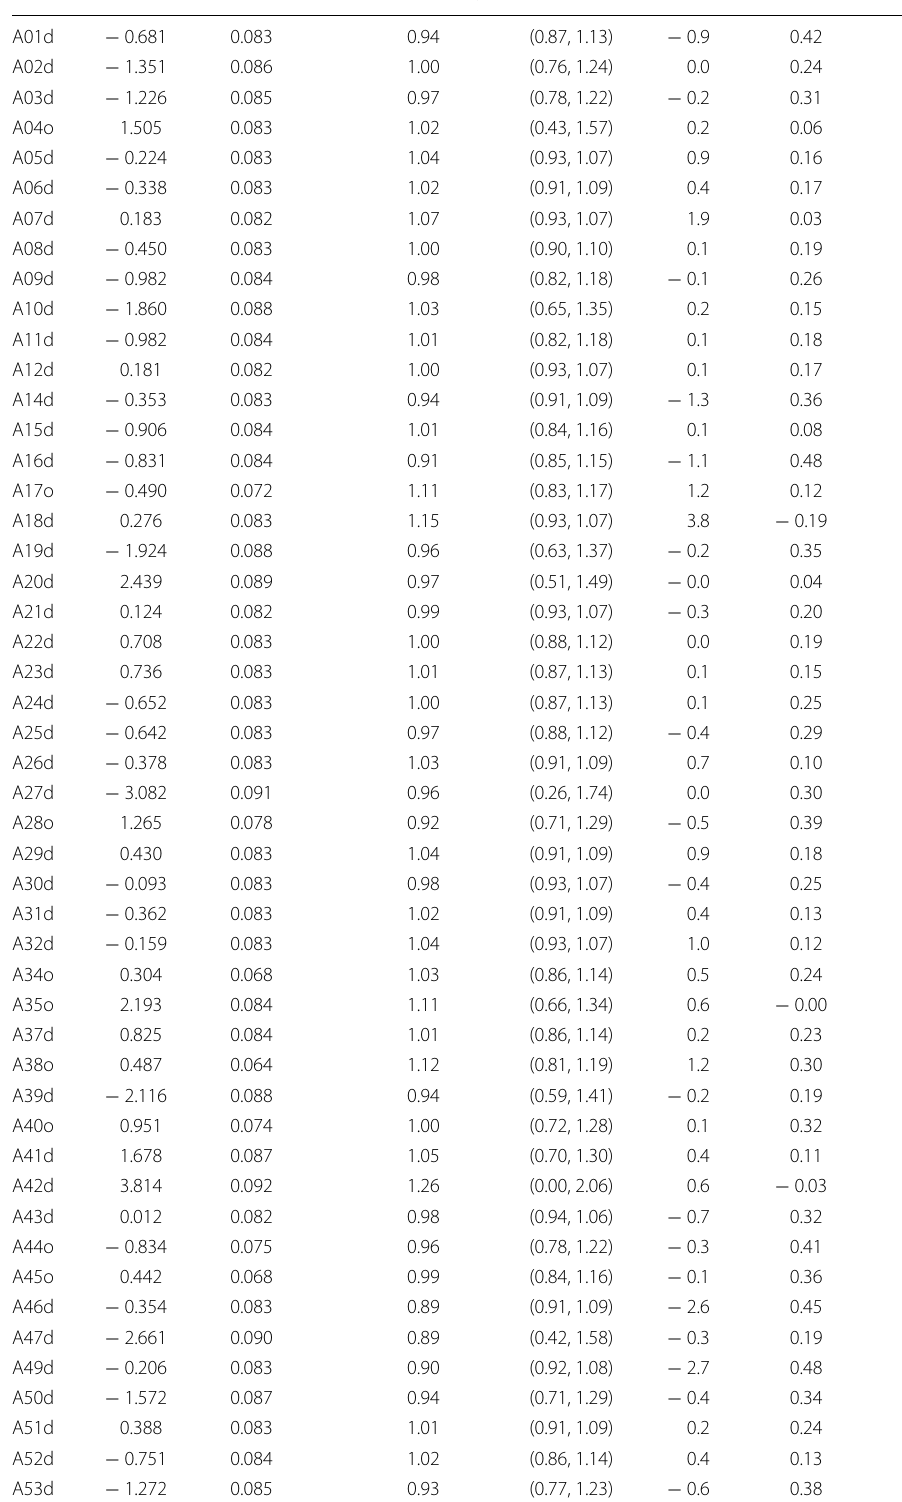
Table 7 Item information for one-dimensional Rasch